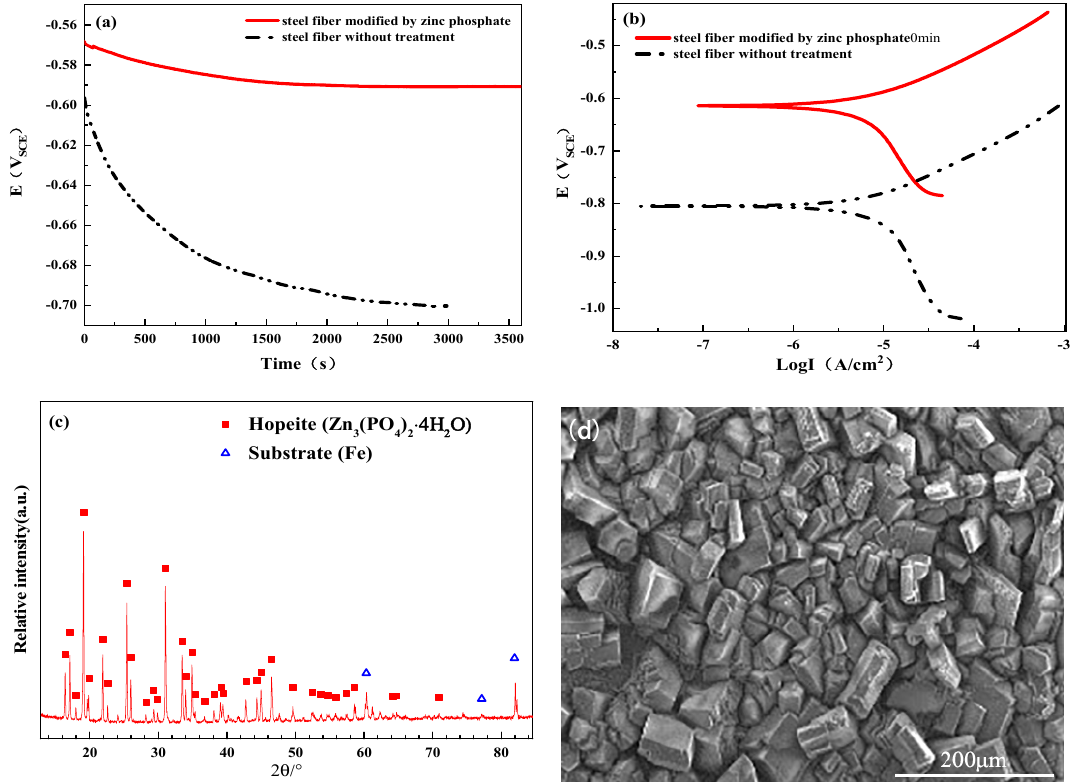
Figure 1. Performance index of the steel fiber modified by zinc phosphate at 75 °C for 20 min: ( a ) ppen circuit voltage, ( b ) polarization curve, ( c ) XRD identification, and ( d ) SEM morphology.